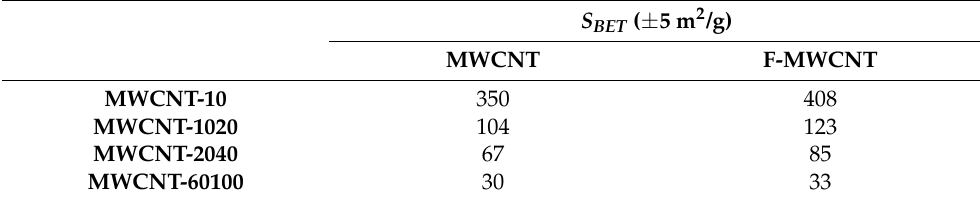
Table 2. Brunauer-Emmett-Teller specific surface area ( S BET ) of pristine and functionalized multi- walled carbon